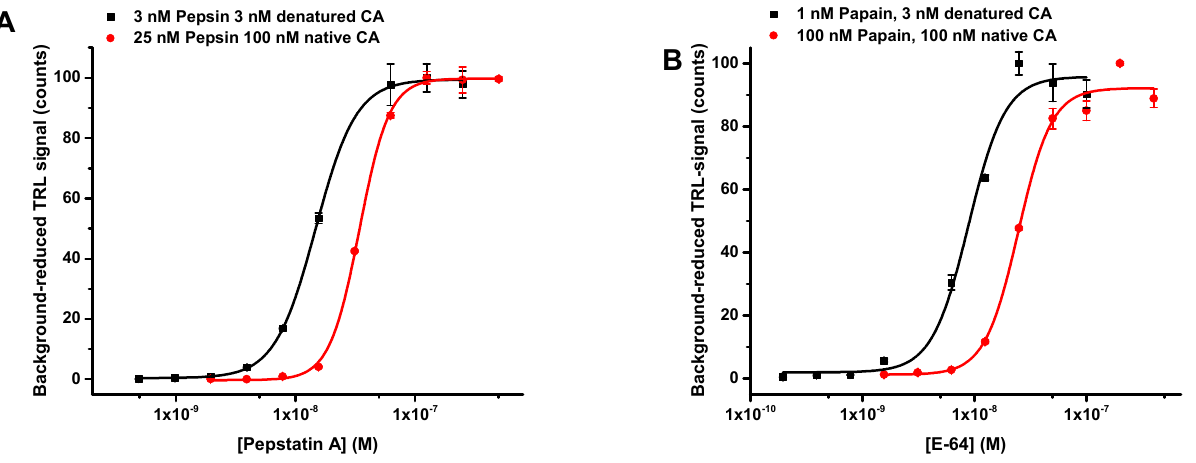
Figure 4. Inhibitor titrations with pepstatin A and E-64 for pepsin and papain with intact and denatured CA as a digested substrate. ( A ) Pepstatin A titration was performed using 25 nM pepsin for intact (100 nM, red) and 3 nM pepsin for denatured (3 nM, black) CA. The monitored IC 50 values were 34.3 ± 0.5 nM and 14.7 ± 0.2 for intact and denatured CA, respectively. ( B ) E-64 inhibition was studied with 100 nM papain for intact (100 nM, red) and denatured (3 nM, black) CA. The monitored IC 50 values were 24.7 ± 1.8 and 8.9 ± 0.9 nM for the native and denatured CA, respectively. With both inhibitors the EC 50 values obtained using the protein-probe technique were similar to those reported previously. Data represent mean ± SD ( n = 3).